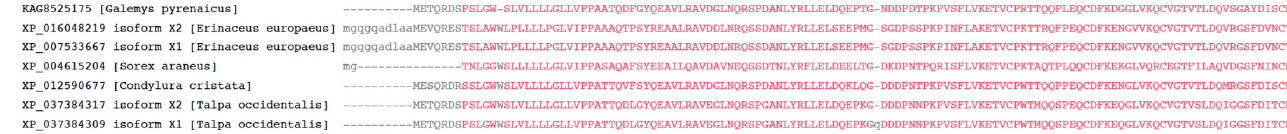
Figure 3. Alignment performed with the Constraint-based alignment COBALT [17] tool of the amino acid sequence of exons 1-3 of NBCI-annotated cathelicidins (accessed on May 2022) from the Eulipotyphla order. Sequences comprise the Iberian desman ( Galemys pyrenaicus ), the European hedgehog ( Erinaceus europaeus ), the common shrew ( Solex araneus ), the star-nosed mole ( Condylura cristata ) and the Iberian mole ( Talpa occidentalis ). Identical amino acids among all sequences are high- lighted in red.